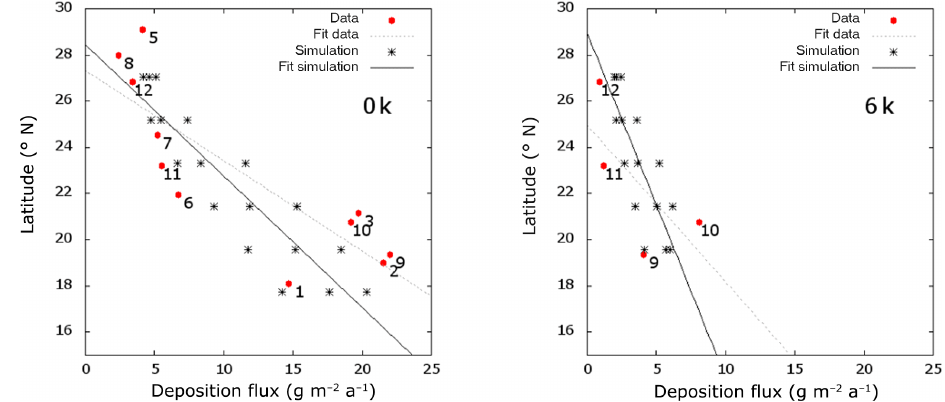
Figure 5. Simulated dust deposition flux for the three ocean grid cells that are closest to the northwest African margin for 0 k (left) and 6 k (right) at different latitudes compared with data from marine sediment cores and sediment traps (Table 4). The straight lines are linear interpolations obtained with the least square method.